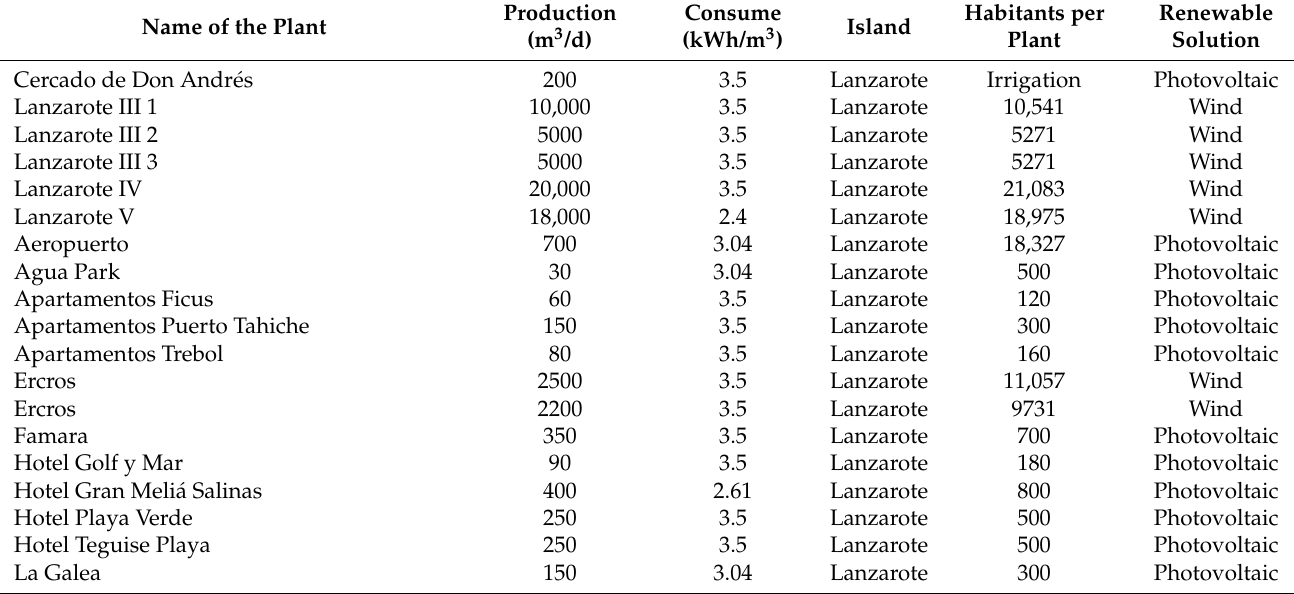
Table 6. Existing seawater desalination plants in the Canary Islands, consumption and solution of renewable energies. Source: FCCA 2013, REE 2020 and own